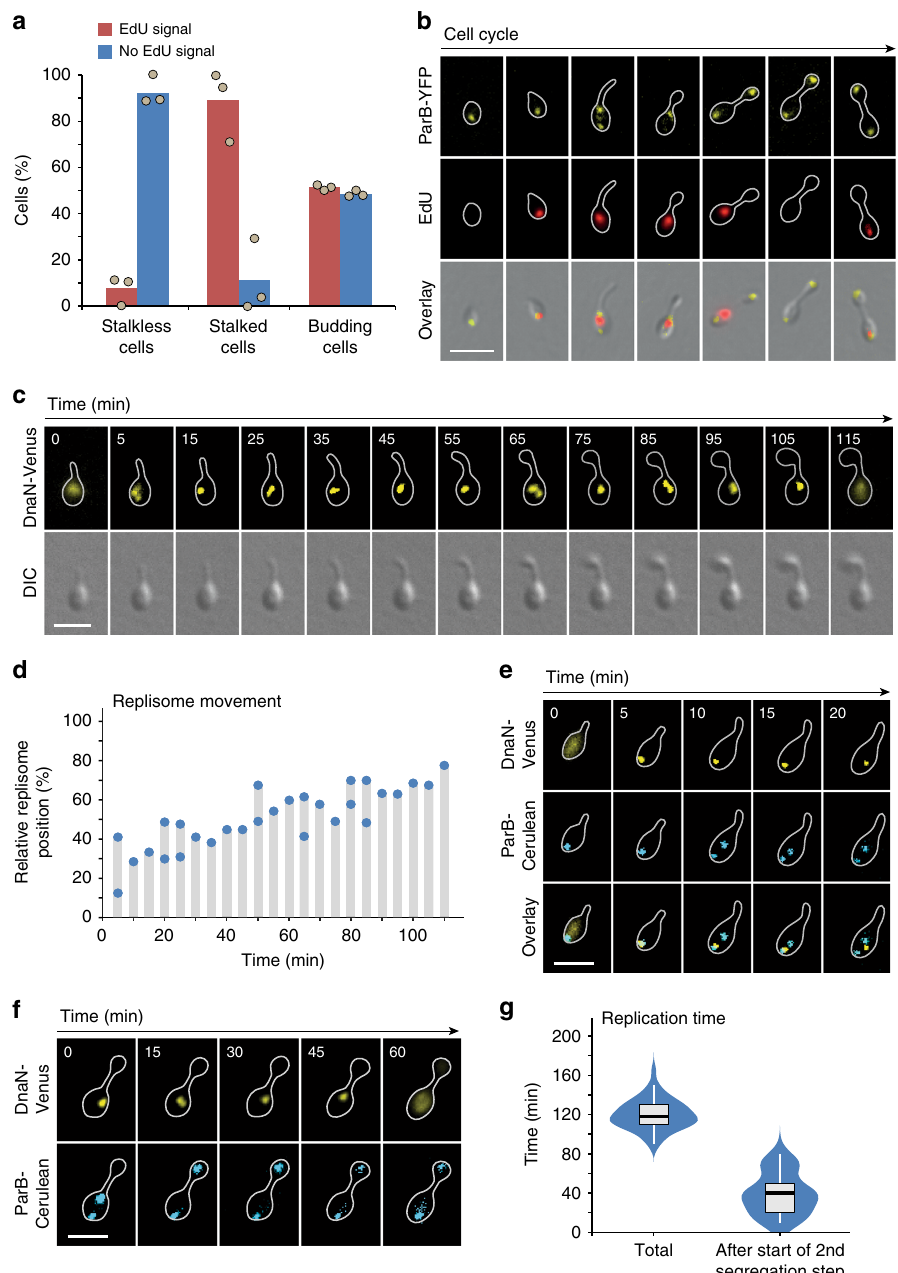
Fig. 9 Dynamics of DNA replication in H. neptunium . a Quanti fi cation of S-phase cells at different stages of the developmental cycle. Exponentially growing wild-type cells were exposed to a pulse of the nucleotide analog EdU. After fi xation and derivatization of the incorporated EdU with the red fl uorescent dye Alexa 954, images were taken and the proportion of cells showing a fl uorescence signal was determined for each of the indicated categories. Data represent the average of three experiments. b Localization of newly replicated DNA in H. neptunium . Strain KH22 ( parB-yfp ) was labeled with EdU as described in ( a ). Shown are representative images of cells at different developmental stages. Bar: 3 μ m. c Time-lapse series showing the movement of the replisome along the two chromosomal arms. Cells of strain RP4 ( dnaN-venus ) were grown in MB medium, transferred to a 25% MB-agarose pad, and imaged at 5 min intervals. Only selected frames are presented. The full time-lapse series is shown in Supplementary Movie 1. Bar: 2 µ m. d Quantitative analysis of replisome movement. The graph indicates the relative subcellular locations of the DnaN-Venus signals in the different frames of Supplementary Movie 1, with 0% indicating the old (previously fl agellated) pole and 100% the future stalked pole of the mother cell. For frames in which the two replication forks were clearly separated, the positions of both DnaN-Venus foci are given. e Colocalization of the replisome with the ParB· parS complex at the beginning of S-phase. Strain JR47 ( dnaN-venus parB-cerulean ) was grown in MB medium, transferred to a 25% MB-agarose pad, and imaged at 5 min intervals. Bar: 2 µ m. f Time-lapse series showing the dynamics of ori and replisome movement towards the end of S-phase. Cells of strain JR47 ( dnaN-venus parB-cerulean ) were grown in MB medium, transferred to a 25% MB-agarose pad, and imaged at 15 min intervals. Bar: 2 µ m. g Quanti fi cation of the total replication time ( n = 50 cells) and the interval between the start of the second segregation step and replisome disassembly ( n = 30 cells). The data were obtained by analysis of the time-lapse series described in ( d ) and ( f ) and represented as box plots. The horizontal line indicates the median, the box the interquartile range, and the whiskers the 5th and 95th